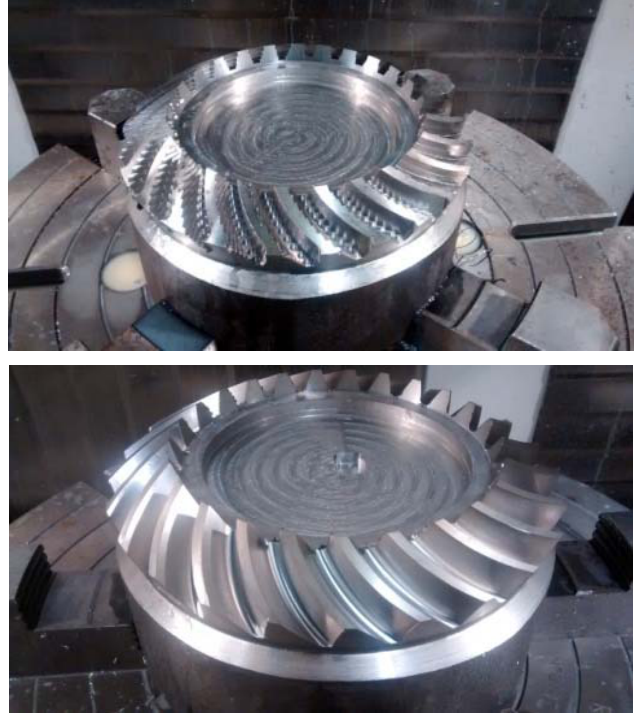
Figure 13. Gear after rough ( top ) and finish machining ( bottom ).